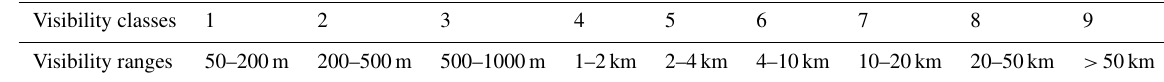
Table 2. The WMO empirical scale for visibility observations, used at NOA. Visibility classes Visibility